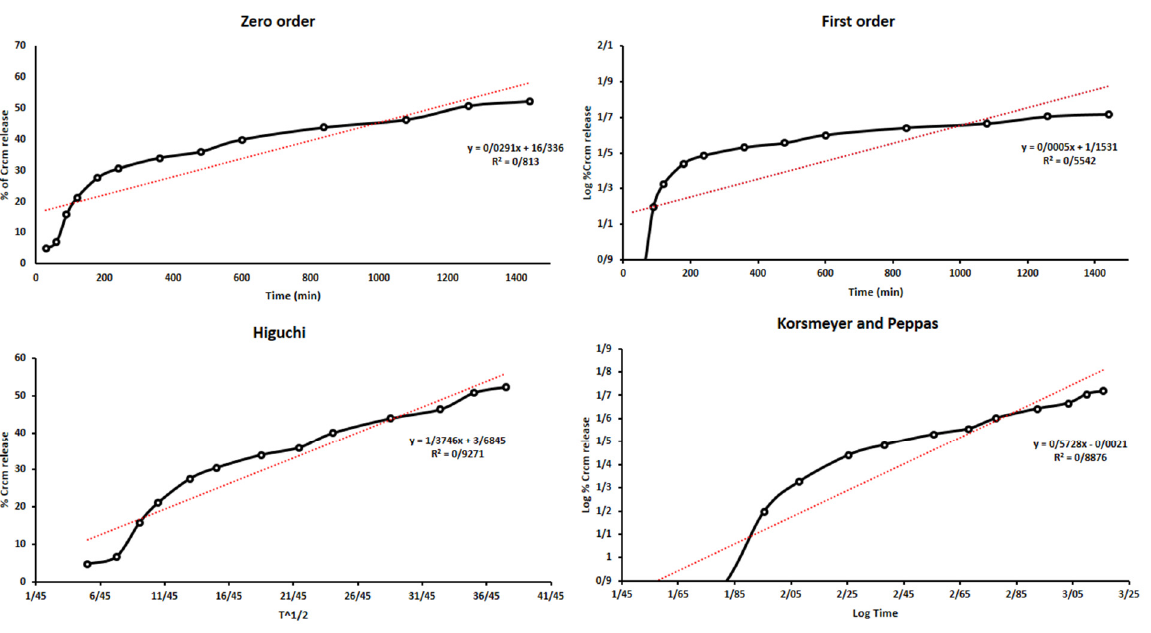
Figure 3. Profiles of different kinetic modes for release of curcumin from microemulsion; the black line is fitting mode of different kinetic release models, and red line is linear fitting.